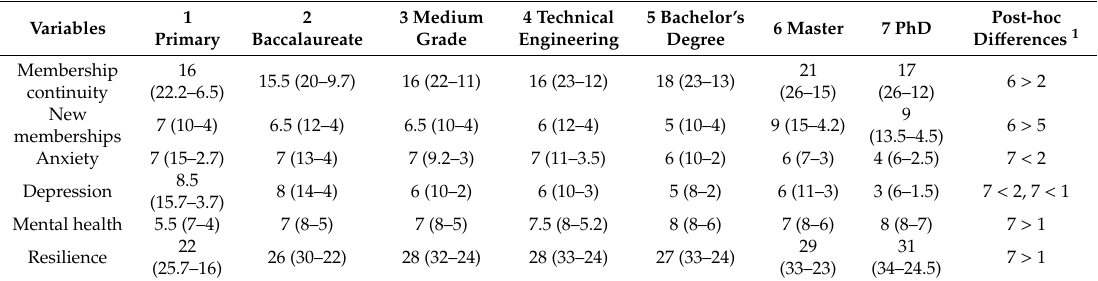
Table 4. Descriptives (Md (IQR)) and post-hoc di ff erences by educational